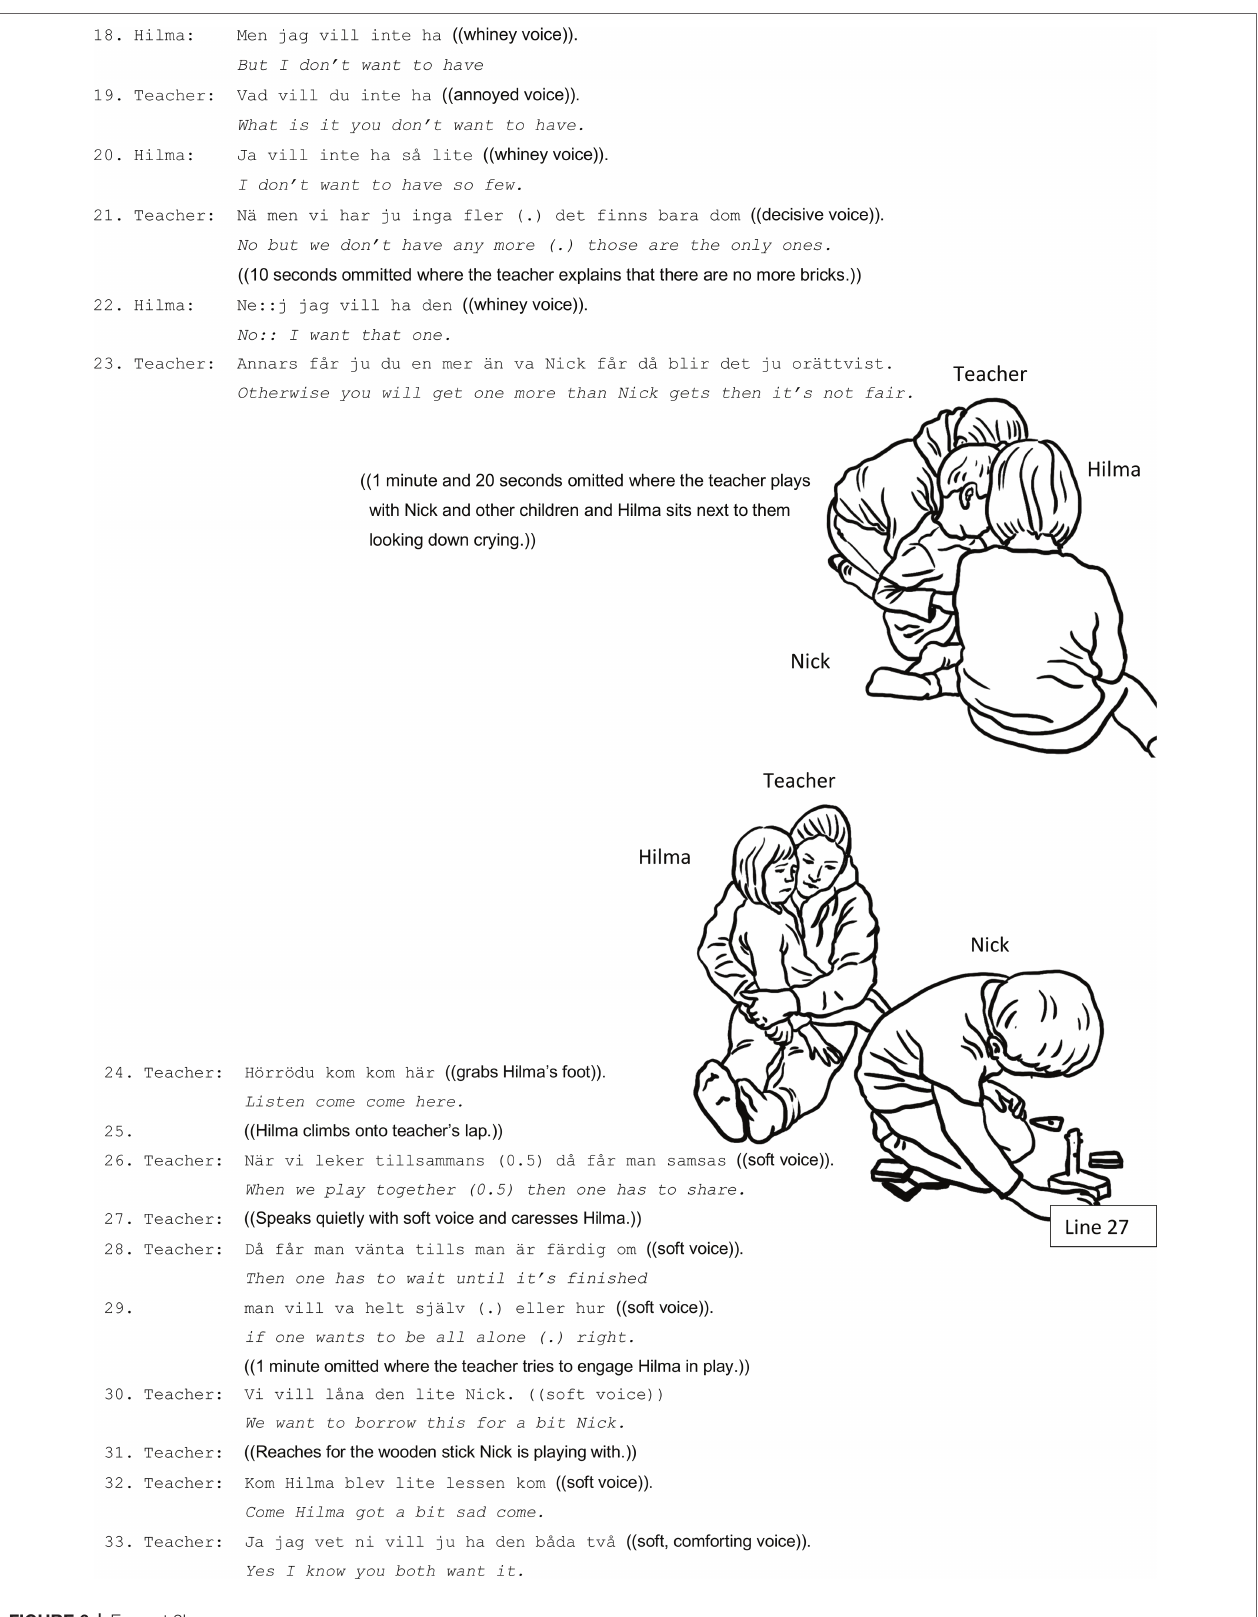
FIGURE 6 | Excerpt